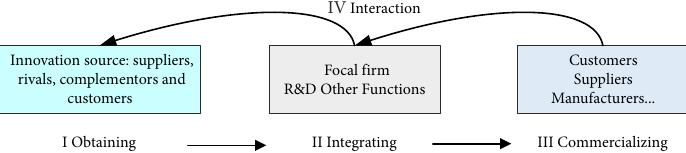
Figure 3. A four-phase process model for using external innovation sources